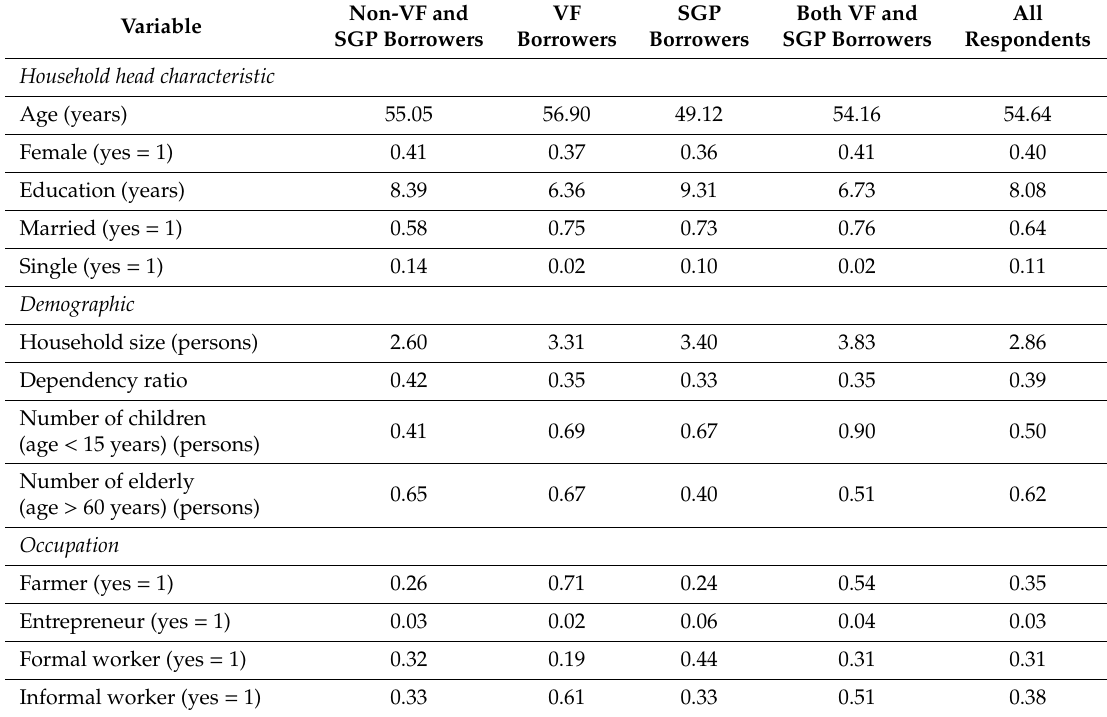
Table 2. Characteristics of borrower households and non-borrower households from Microfinance Institutions (MFIs) using cross-sectional data from the 2017 Household Socio-Economic Survey. Non-VF and VF SGP Both VF and All Variable SGP Borrowers Borrowers Borrowers